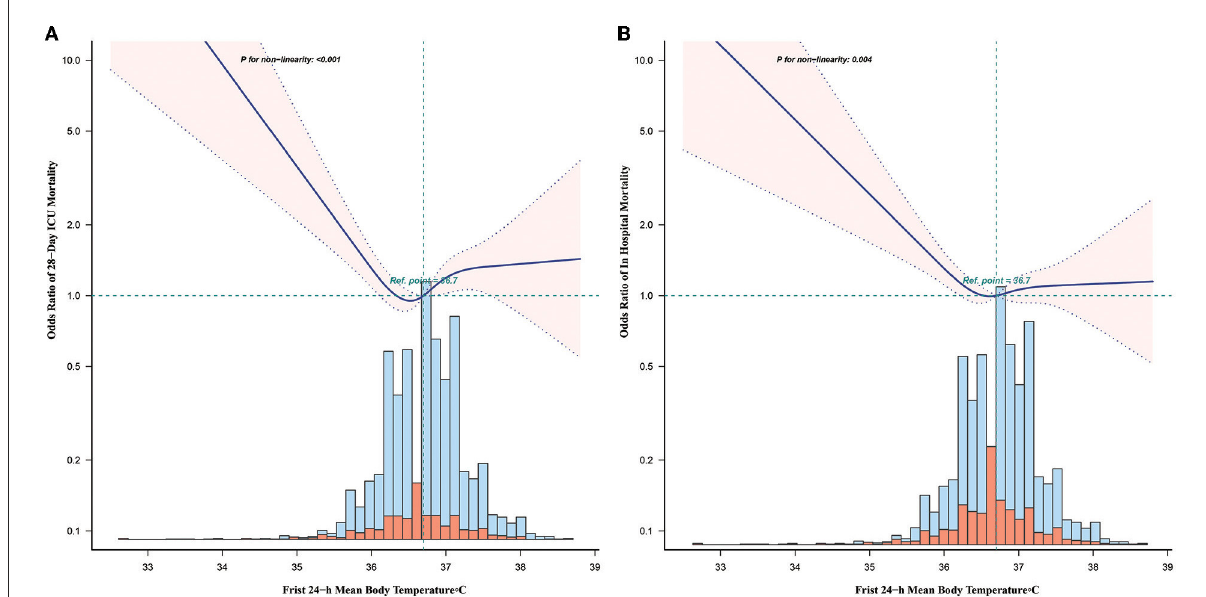
FIGURE2 Non-linear relationship between BT and 28-day ICU mortality (A) and in-hospital mortality (B) . Adjustment factors included gender, age, marital status, ethnicity, weight, WBC, albumin, BUN, INR, PTT, anion gap, bicarbonate, calcium, chloride, sodium, HR, SBP, DBP, MBP, RR, SpO2, the presence of renal disease, the presence of severe liver disease, the presence of malignant cancer, the presence of myocardial infarction, the presence of cerebrovascular disease, the presence of peripheral vascular disease, the presence of diabetes, the presence of chronic pulmonary disease, and